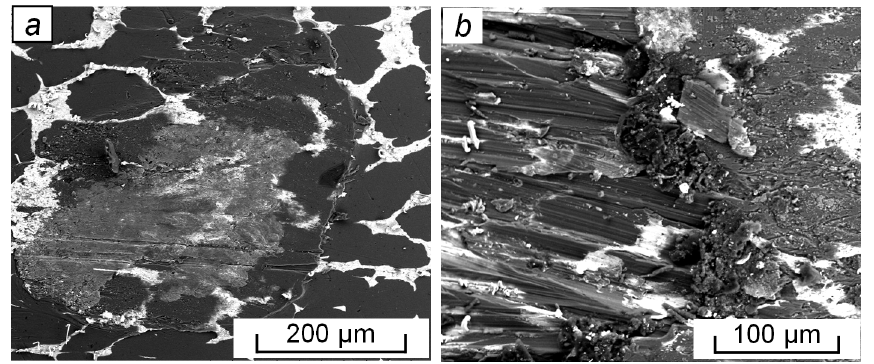
Figure 9. SEM images of the friction surface of the sintered Al-30Sn sample after 1 ( a ) and 10 ( b ) passes along the friction track; P = 1 MPa; V sl = 0.07